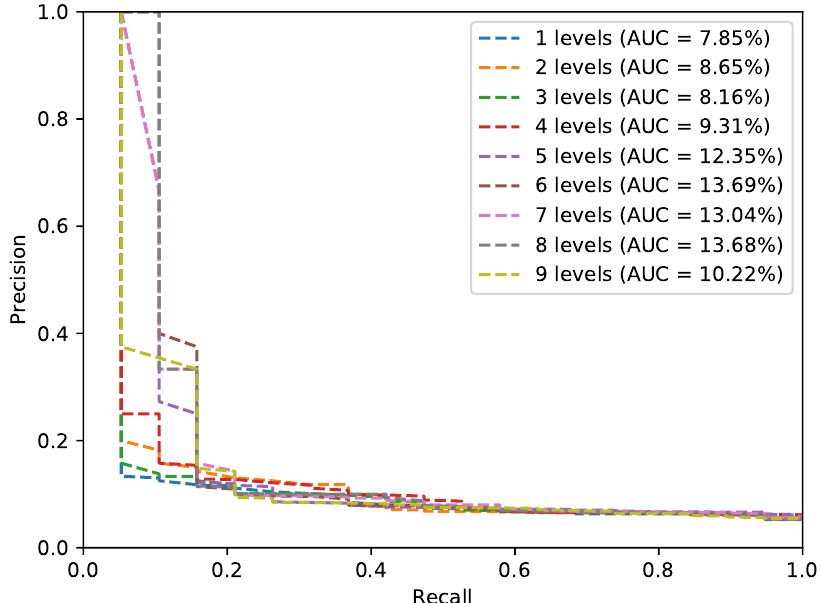
Figure 8. Precision-Recall curves and related Area Under The Curves ( AUC ) according to the number of levels description used in PHROG when applied on the VPrice dataset.